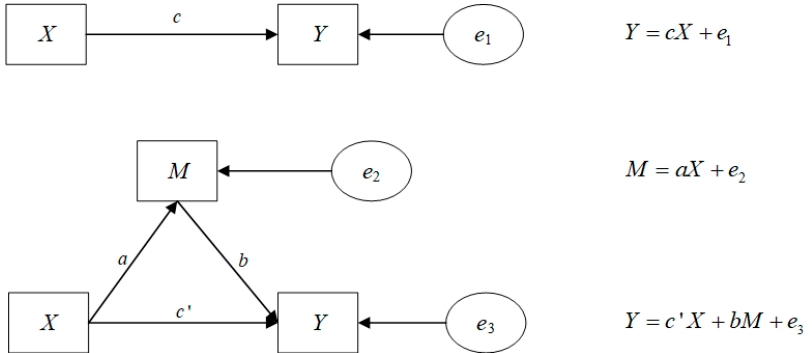
Figure 3. Mediation effect model.